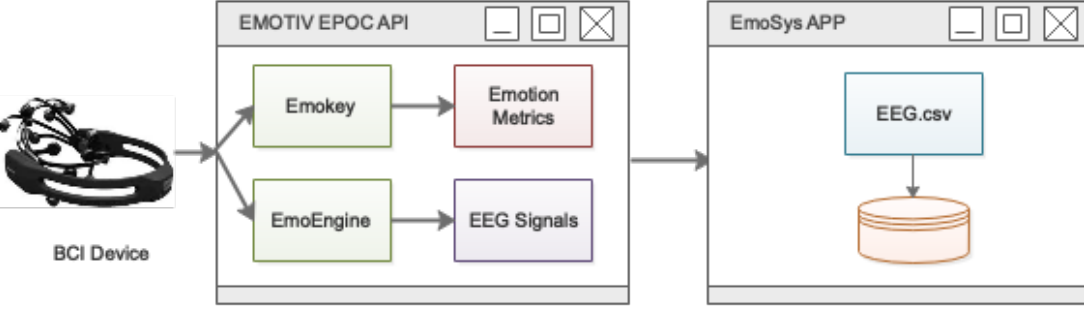
Figure 2. EmoSys software suite.